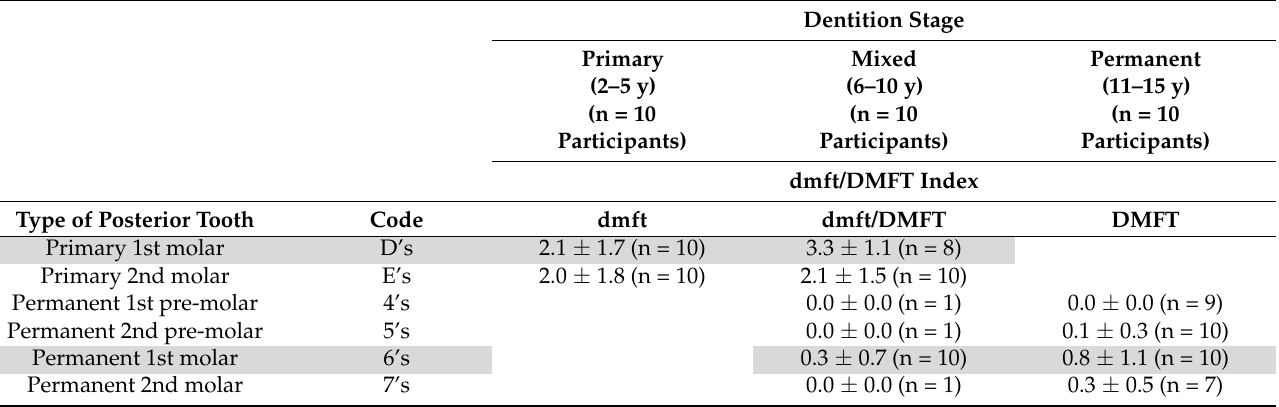
Table 1. Summary of the samples collected in the study. The occlusal plaque of individual posterior teeth (87 samples) was collected from the thirty enrolled participants, and the samples were stratified into three groups according to the dentition stage. The caries experience of each tooth was evaluated using dmft/DMFT index; the respective average per tooth type is indicated in the